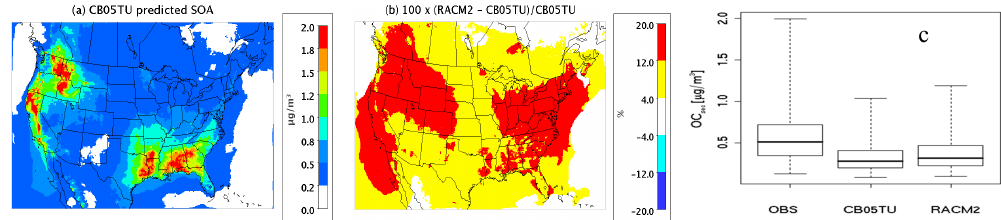
Figure 11: (a) Predicted mean Secondary Organic Aerosols with CB05TU (b) percent differences in mean Secondary Organic Aerosols between RACM2 and CB05TU (c) a comparison of predicted mean Secondary Organic Carbon with values derived from the Interagency Monitoring of Protected Visual Environments network.